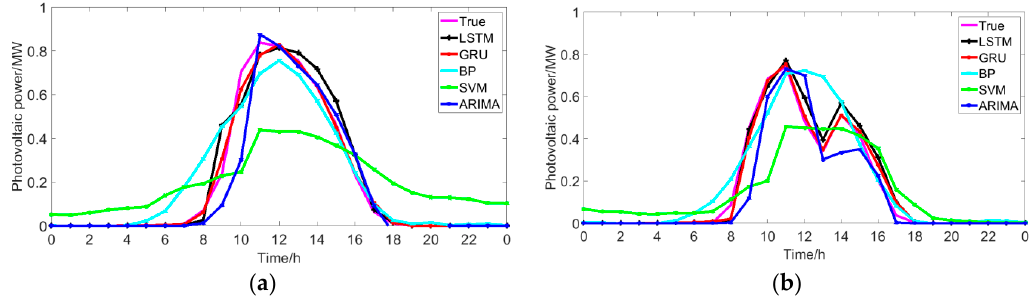
Figure 11. The real photovoltaic power and forecasted photovoltaic power selected from test set randomly. ( a ) Photovoltaic power of 17 June 2014; ( b ) Photovoltaic power of 23 June 2014.